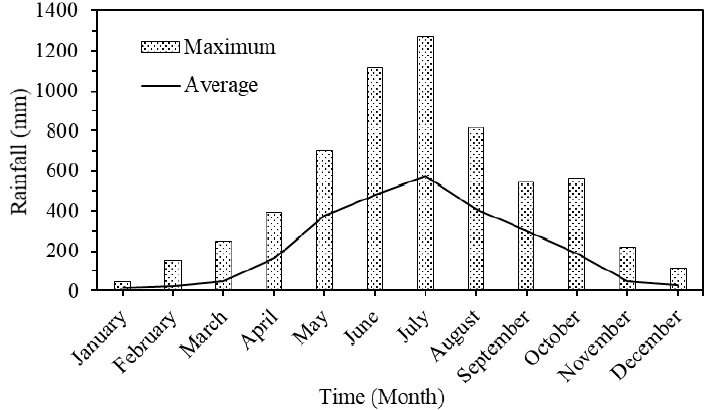
Figure 1. Monthly variation of maximum and average rainfall in Rangamati.